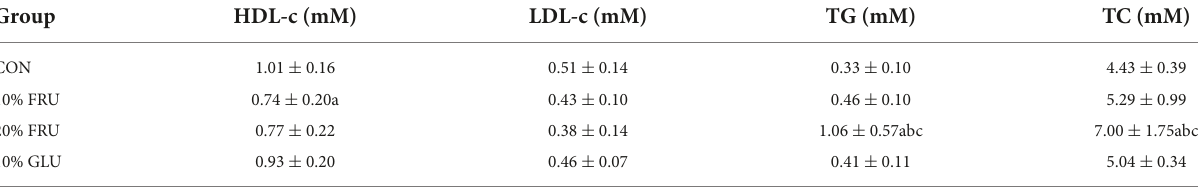
TABLE 1 Serum concentration of HDL-C, LDL-C, TG, and TC in different groups. Group HDL-c